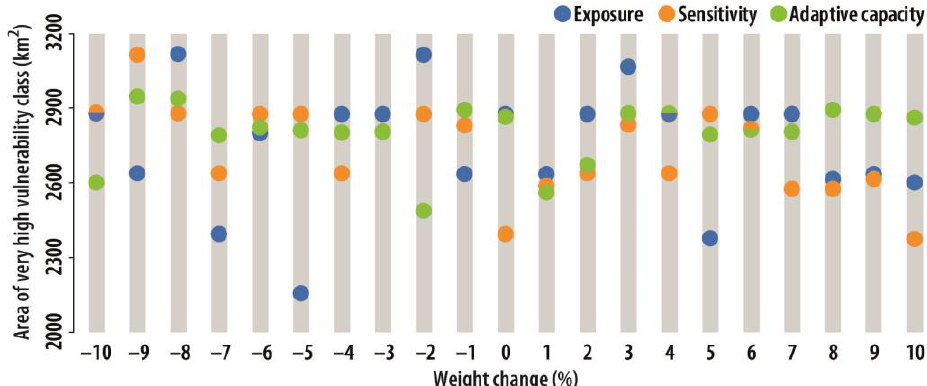
Figure 8. Sensitivity of the areas in the very high level of SDS vulnerability map to the changes in the indicator weights. The average changes in the area of each component’s indicators are presented in the diagram.